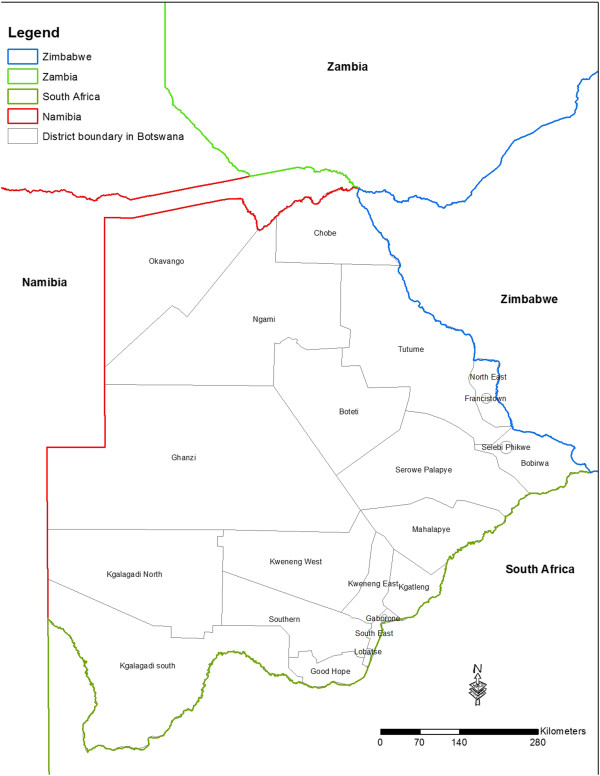
Map of Botswana.